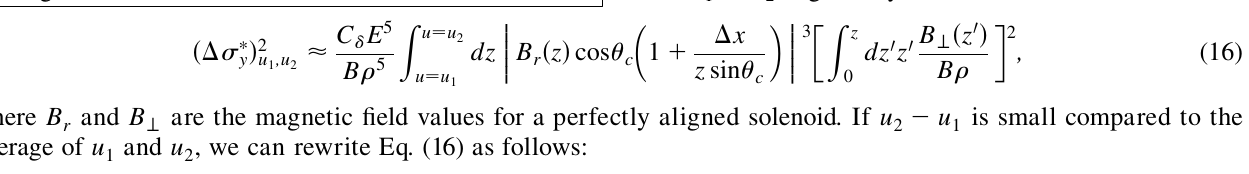
(cid:13) 0 : 77 ]. 2 < u < u , the B contribution to B z 1 2